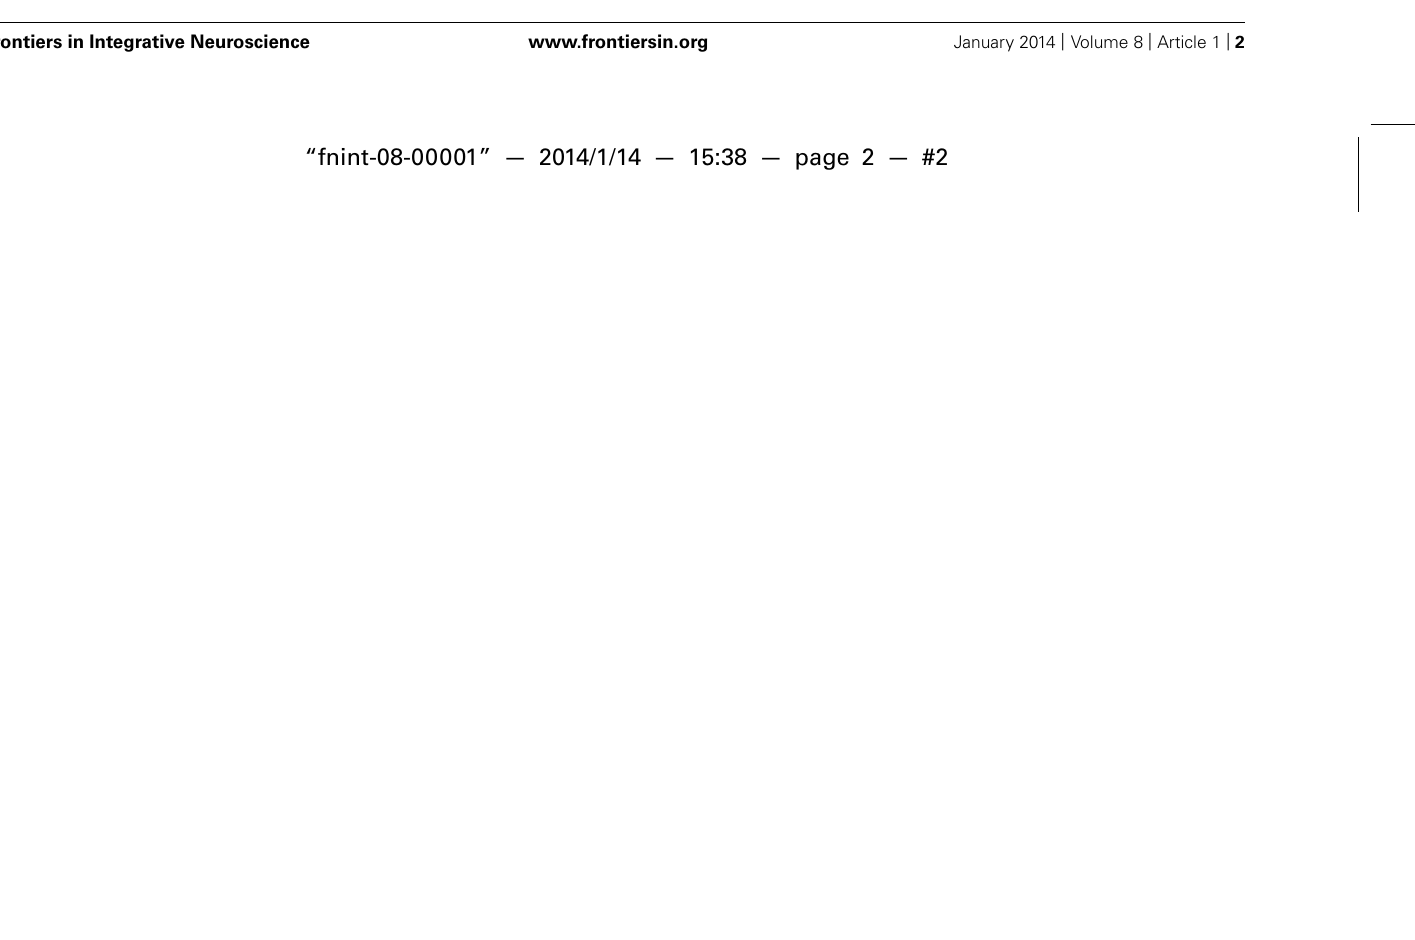
FIGURE 1 | Schematic illustration of a conceptual model of habituation and saliency mapping. (A) The black dots represent a stream of stimuli coming one after the other in time. The horizontal positions represent points on the internal neural representation axis. The statistics of the incoming stimuli are learned and memorized in Stage 1 to create an expectation model that is the expected probability of the internal representation of the next stimulus. The expectation model is illustrated by a normal curve. The blue dot is a new incoming stimulus. In Stage 2, the